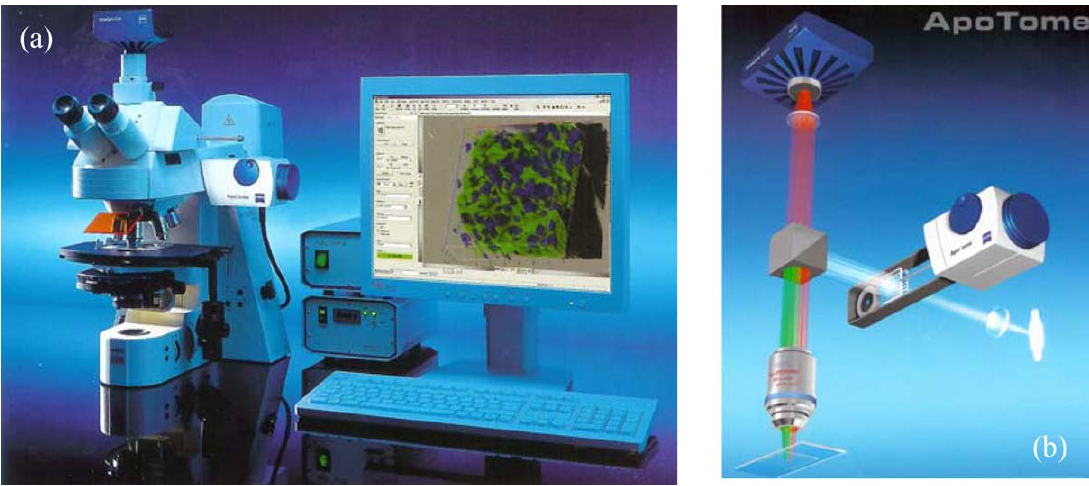
Fig. 3. Axioplan microscope with APOTOME (a) and the illumination and detection light path of the system